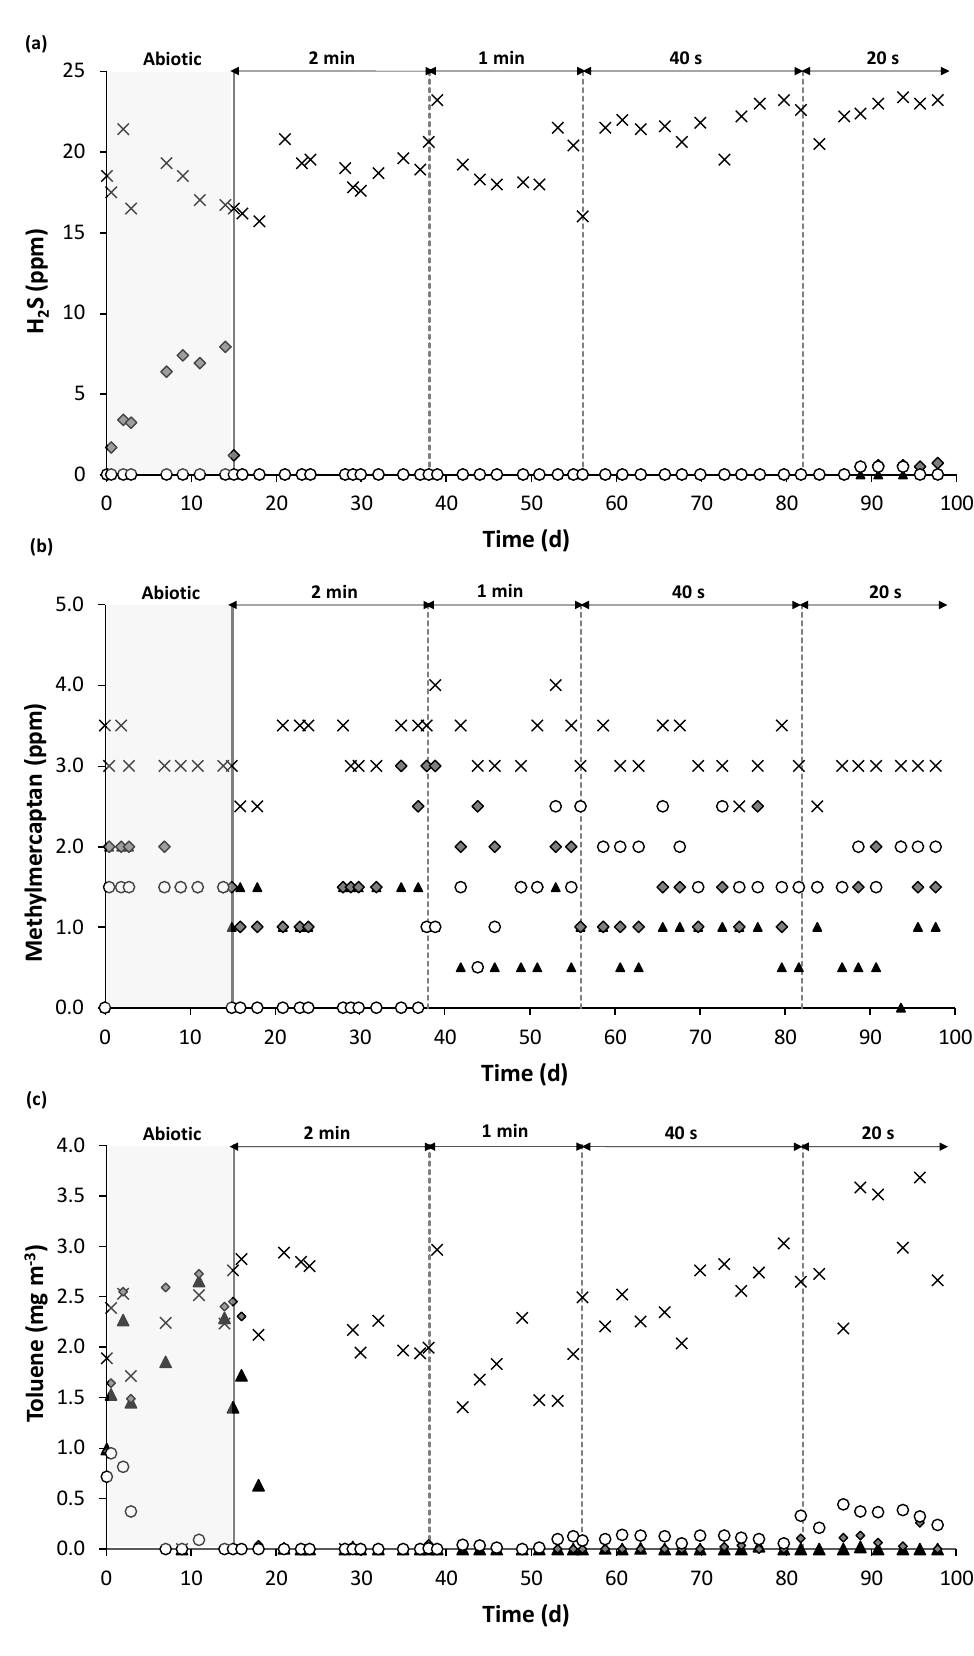
Figure 4. Time course of the inlet ( × ) and outlet concentration of H 2 S ( a ), methylmercaptan ( b ) and toluene ( c ) in BF-F ( (cid:7) ), BF-FAC ( (cid:78) ) and 2PBTF-F ( ). Vertical dashed lines delimit different stages. (cid:35)